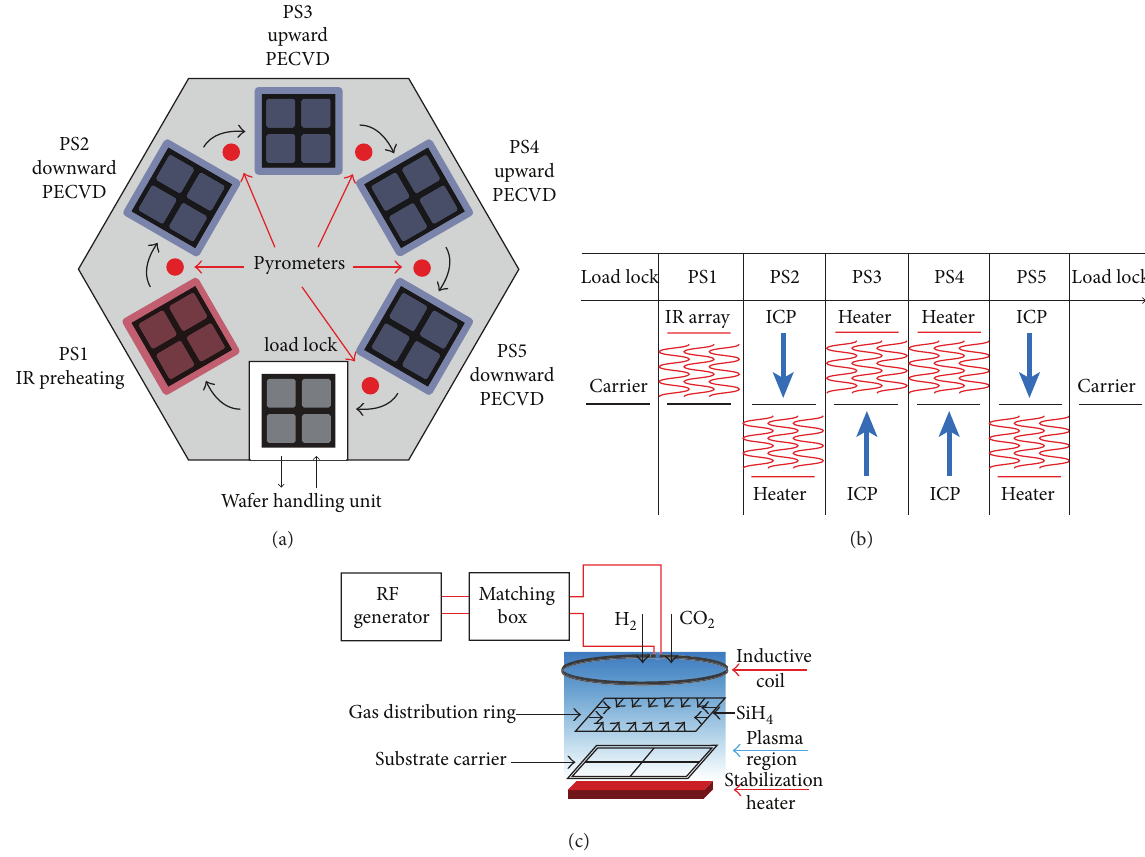
Figure 1: (a) Illustration of processing unit structure of the SINGULAR-HET. The arrows indicate the direction for carrier rotation and transfer. (b) Illustration of the process cycle. The horizontal arrow indicates processing order and the vertical arrows represent the direction of deposition in each station. (c) Illustration of process station and plasma design for plasma stations in downward deposition configuration. After [25, 26].